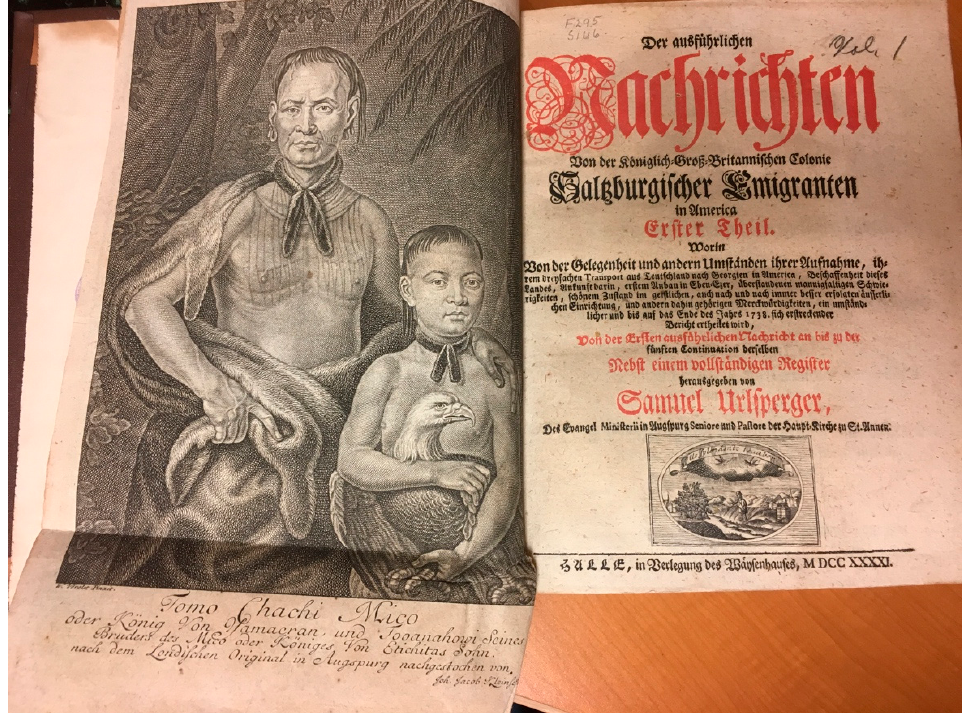
Figure 6. Engraving of Tomochichi and Toonahowi as it appears in the Detailed Reports (Urlsperger 1741). Samuel Urlsperger, ed. Der ausführlichen Nachrichten von der Königlich-Groß-Britannischen Colonie Salzburgischer Emigranten in America Erster Theil (Halle: in Verlegung des Wäysenhauses, 1741). Special Collections, A.R. Wentz Library, United Lutheran Seminary—Gettysburg. Photographed by author.